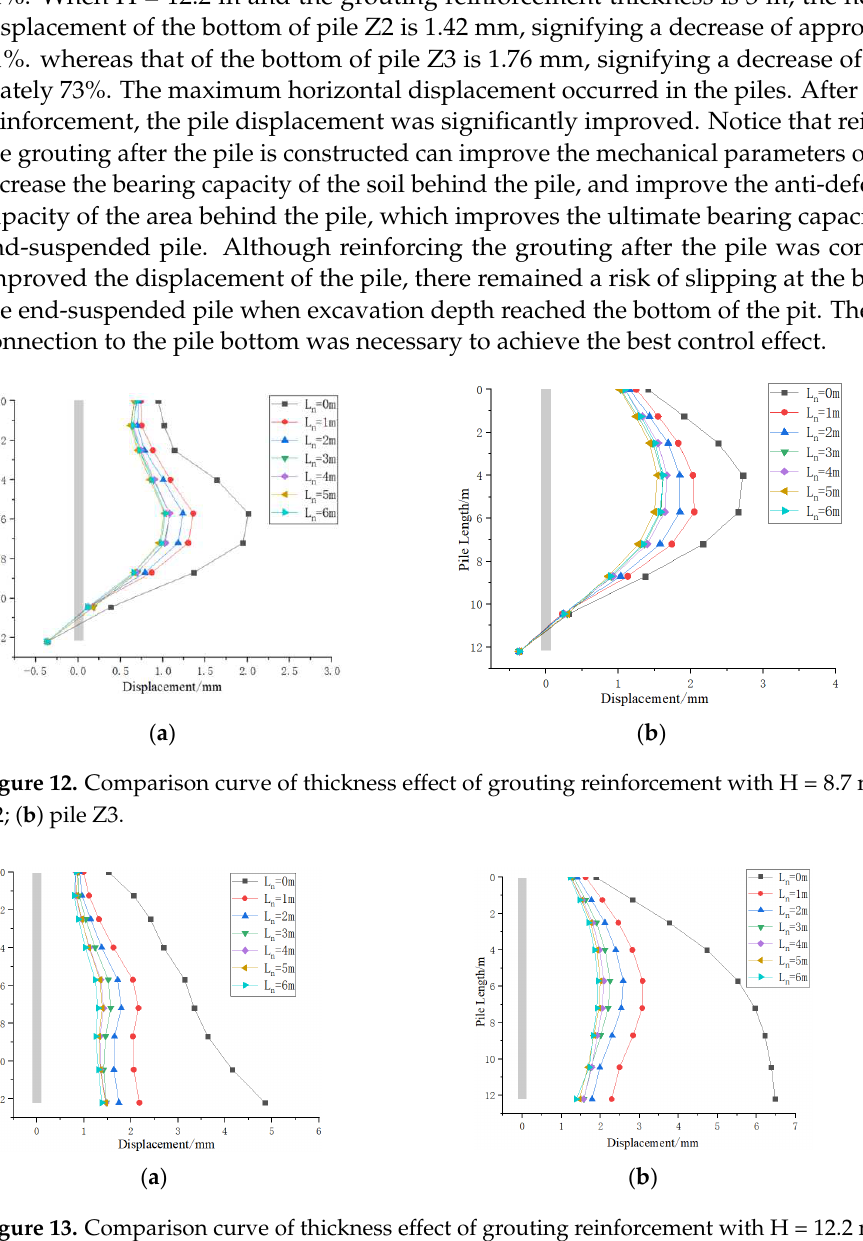
Figure 14. Comparison curve of horizontal displacement of end-suspended pile with H = 12.2 m. 4.2. Development of Safety Control Measures After analyzing the effect of several stabilizing control measures on the end-sus- pended pile, we determined that all three control measures play a positive role in stabi- lizing the end-suspended pile. A combination of the three control measures is required to strengthen the end-suspended piles during the construction. 4.2.1. Connection Technology between Pile Bottom and Existing Primary Support Struc- ture When the end-suspended pile excavation reaches to the pilot tunnel top of the exist- ing station, the air pick breaks the primary support structure of the existing station until the geogrid is exposed. Subsequently, the main reinforcement at the pile bottom is con- nected to the primary support geogrid. The primary support geogrid is connected to the